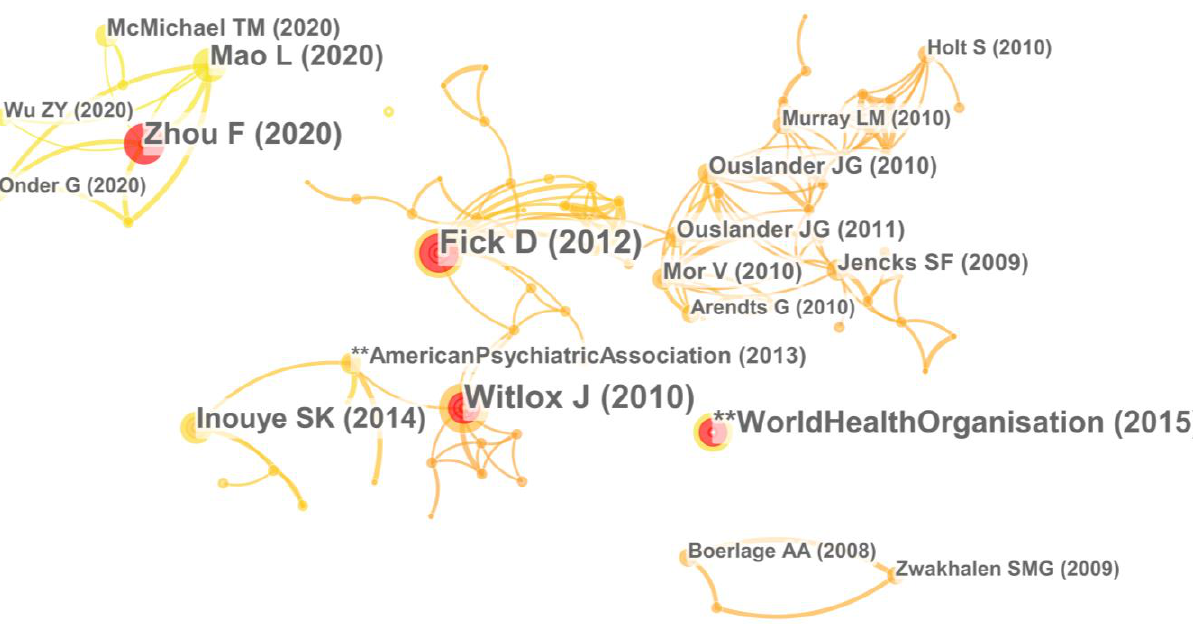
Figure 8. Co-citation map of FCMNCE research literature.